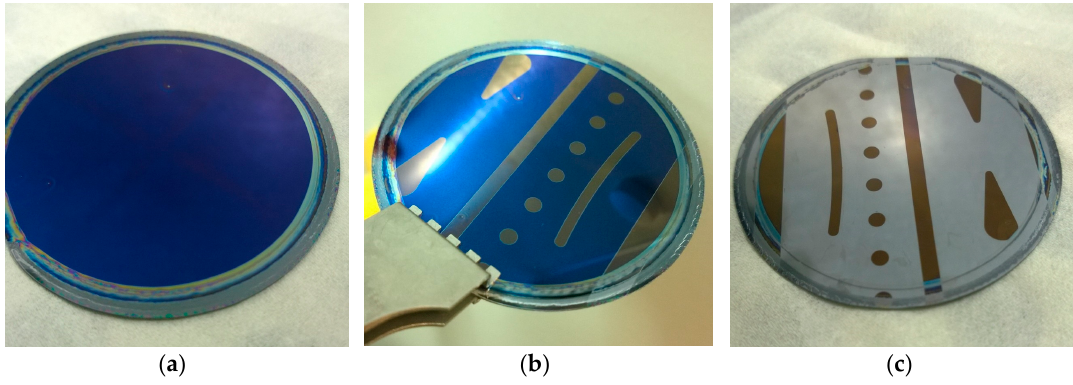
Figure 2. (L to R) Wafer imaging following spin-coating ( a ), post exposure bake ( b ), and final development ( c ) .